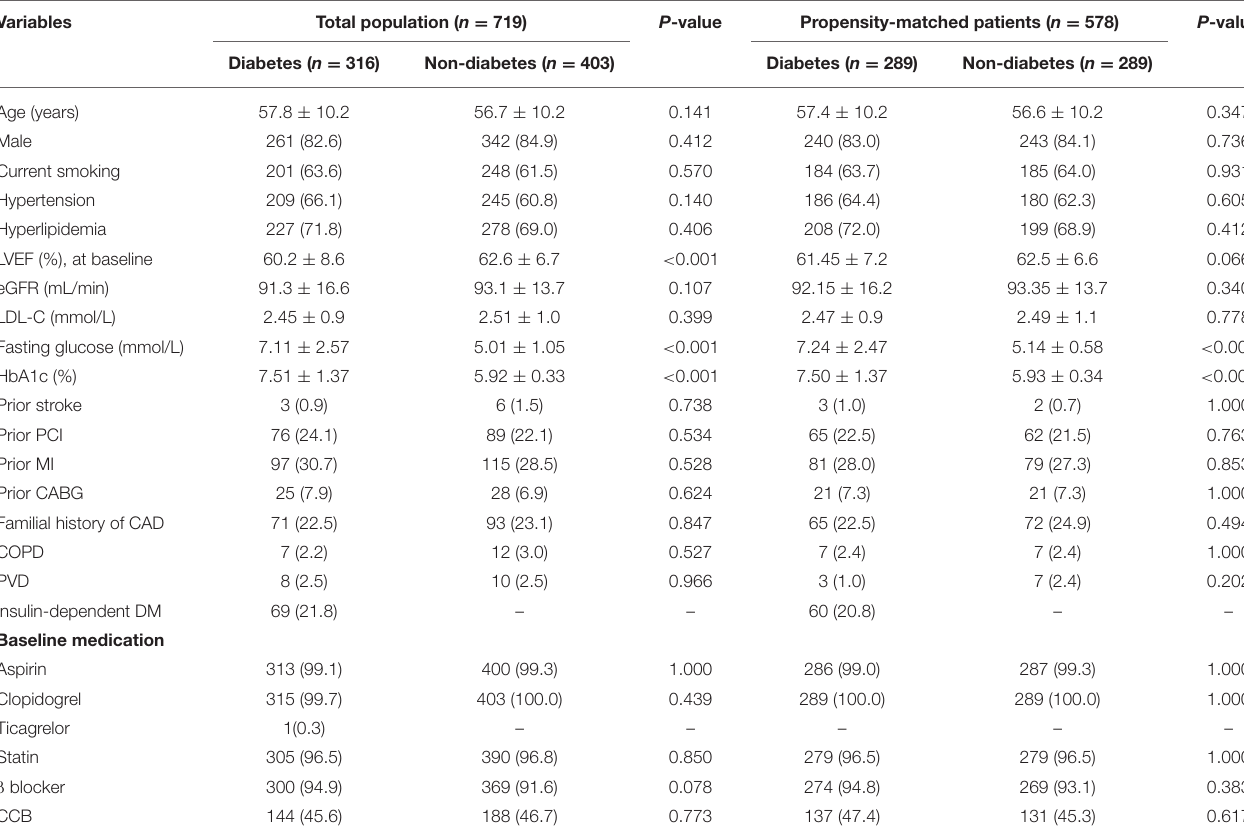
TABLE 1 | Baseline clinical characteristics in the diabetes and the non-diabetes groups. Variables Total population ( n = 719) P -value Propensity-matched patients ( n = 578) P -value Diabetes ( n =